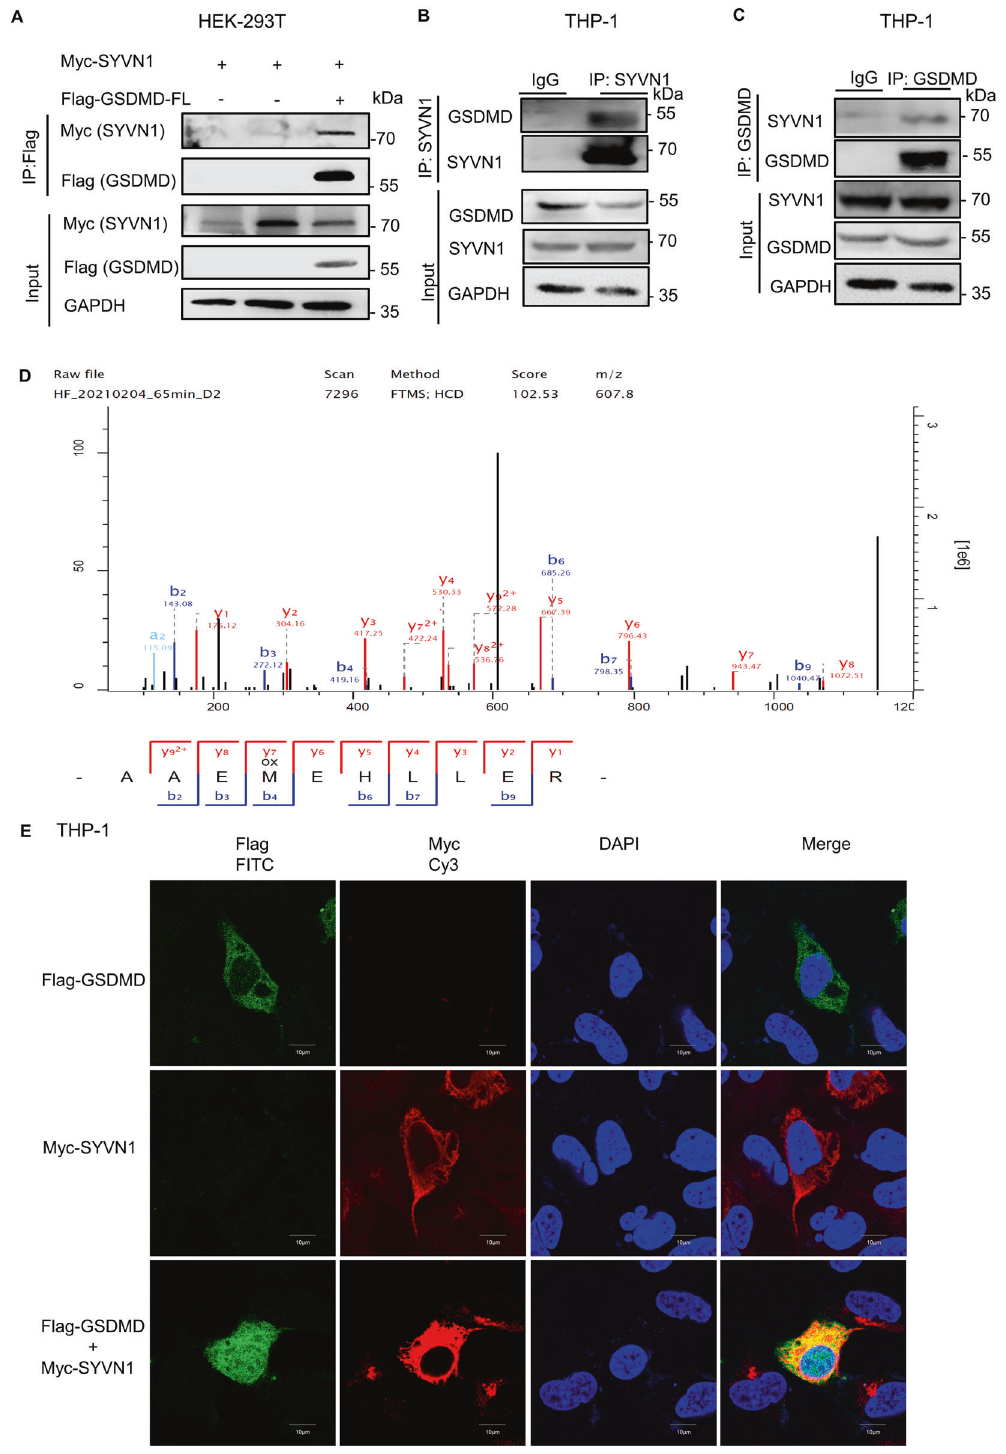
Identi fi cation of SYVN1 as a GSDMD-interacting E3 ligase Since E3 ligase plays an indispensable role in the ubiquitination process, we explored the involvement of this enzyme in GSDMD ubiquitination. Analysis of the UbiBrowser database revealed that SYVN1 is one of the most important E3 ligases involved in GSDMD ubiquitination (Supplementary Fig. 1A). HEK293T cells were then